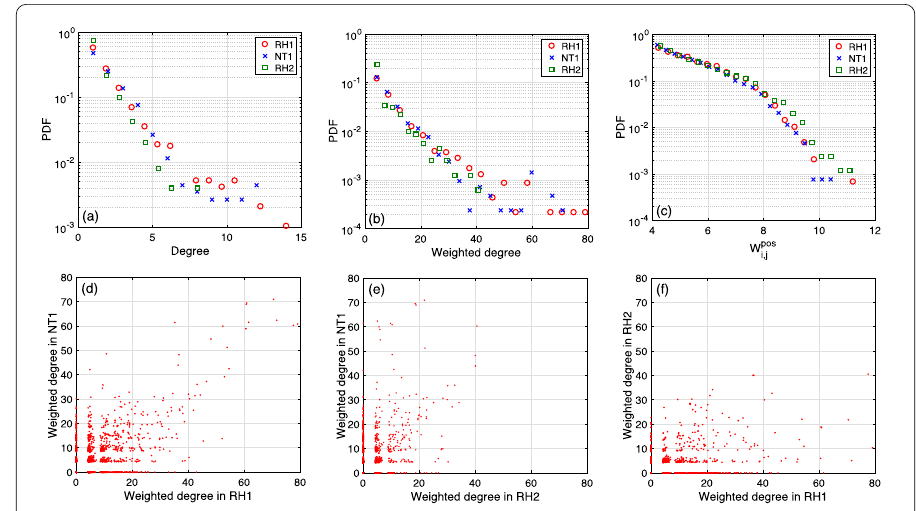
≥ W ≤ D ≥ 0.1, and | τ pos | ≤ 10. min , D i , j max , D i , j i , j i , j